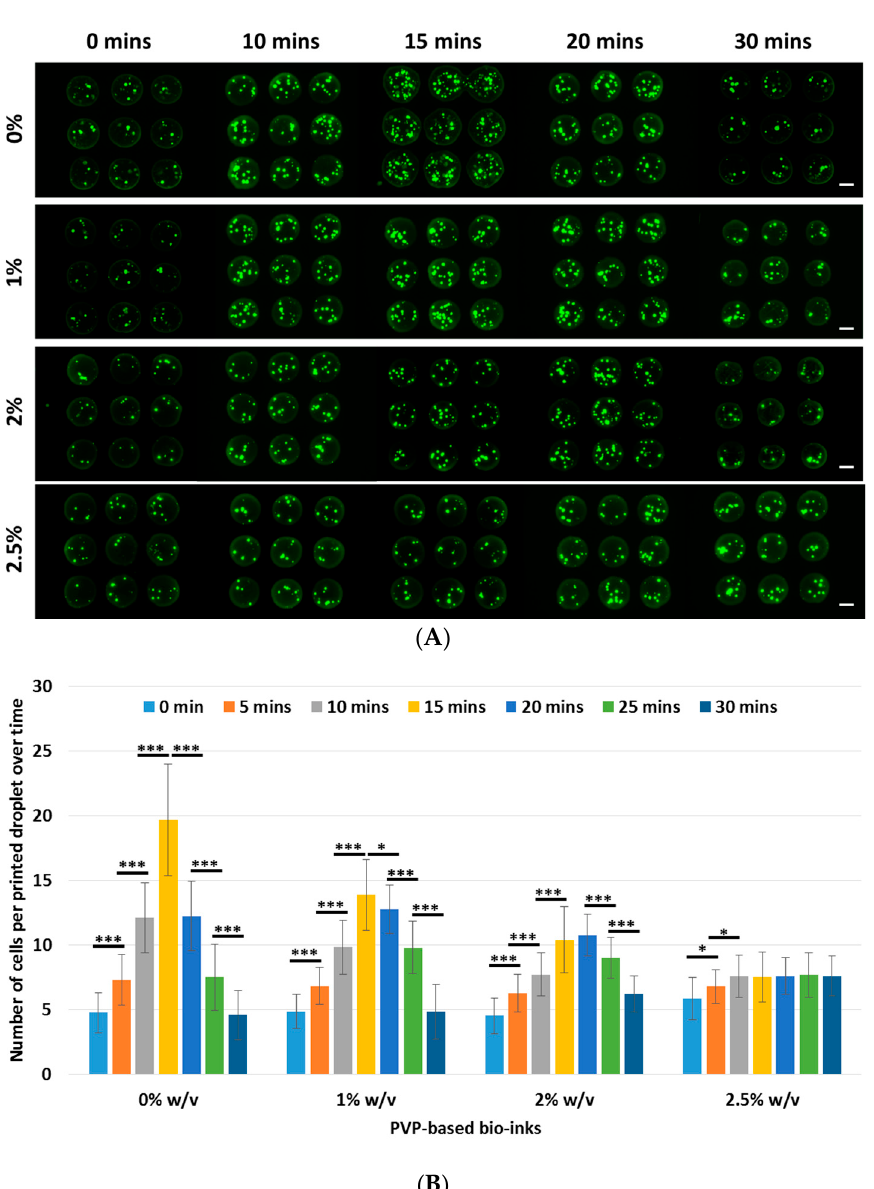
Figure 3. ( A ) Representative images of printed cells (constant cellular concentration of 1.0 mil cells/mL) at different time intervals (scale bar: 200 µm); ( B ) A graph showing the number of cells per printed droplet over time (mean ± SD). Significance levels are as follows: p < 0.005 (***), p < 0.05 (*). The use of PVP-based bio-inks helped to mitigate cell adhesion and sedimentation during the printing process and improved the cell output consistency over